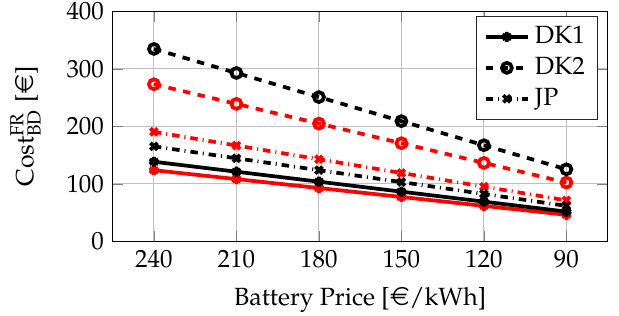
Figure 13. Comparison of Cost FR with battery prices equal to 240, 210, 180, 150, 120 and 90 (cid:164) /kWh. BD In black the cases with SOC = 75% and in red the ones with SOC =